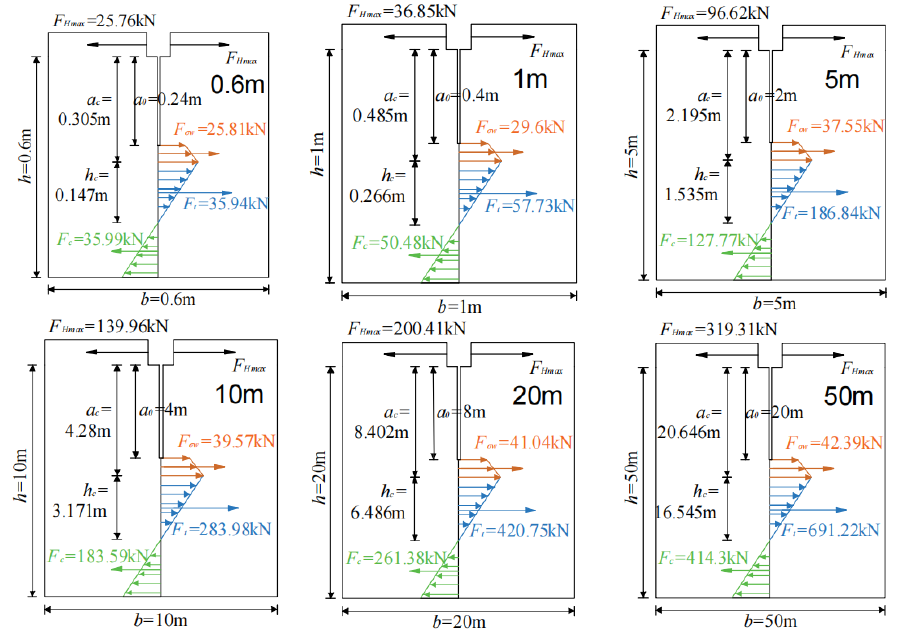
Figure 12. Stress distribution in the midspan section of specimens with different heights.